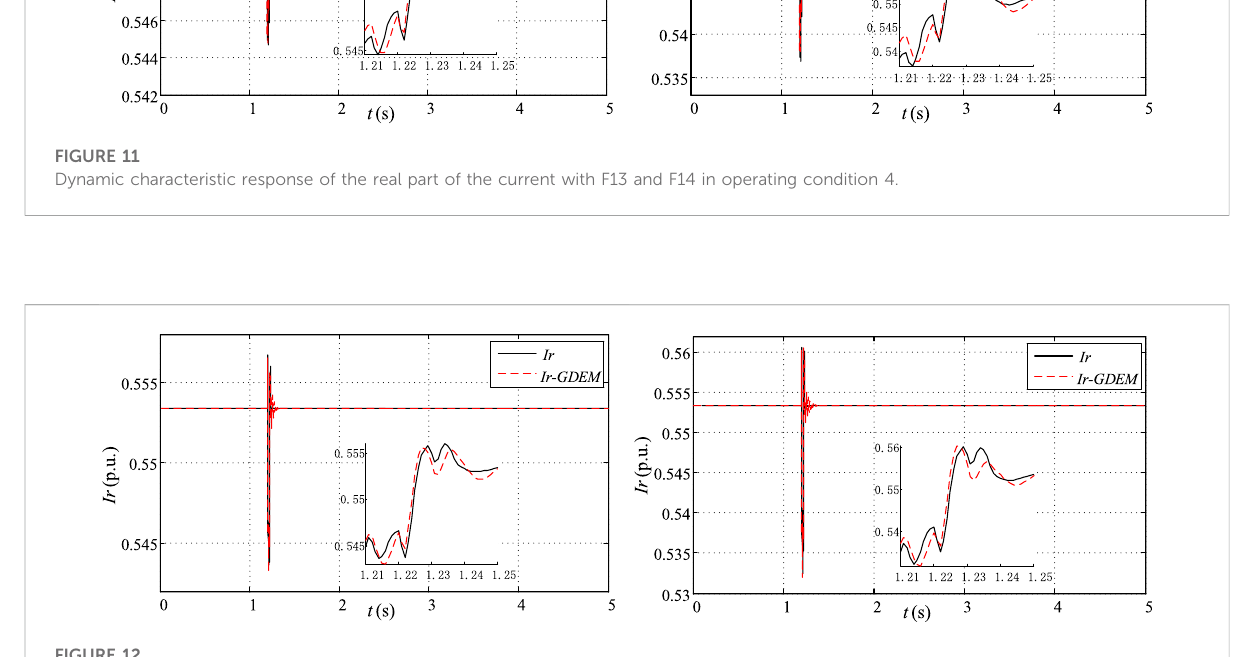
Dynamic characteristic response of the real part of the current with F15 and F16 in operating condition